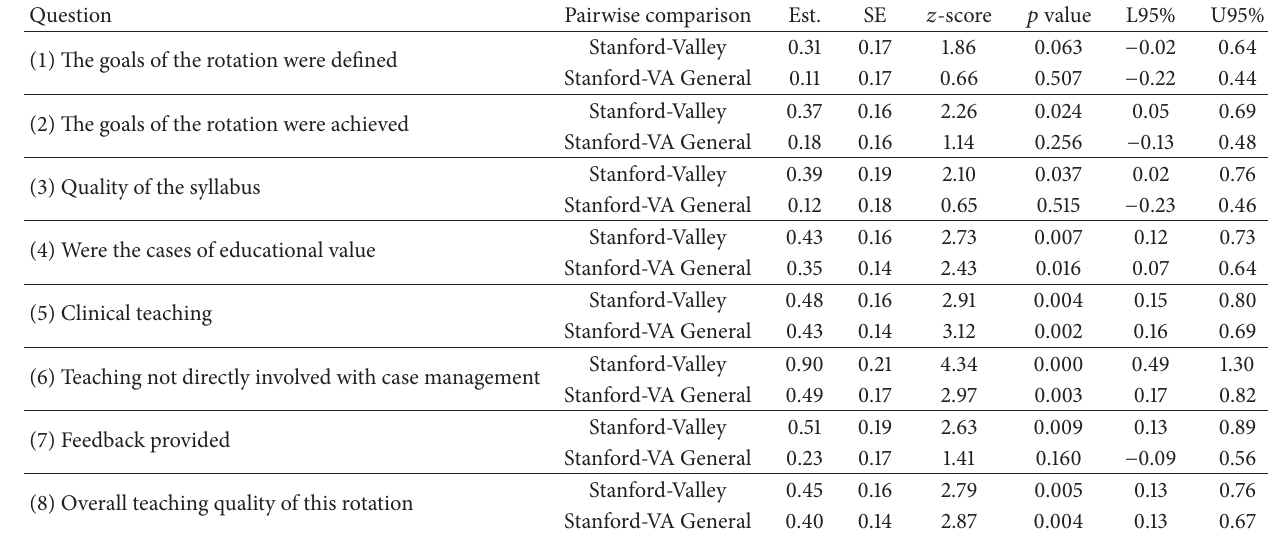
Table 2: Pairwise comparisons for post-pre